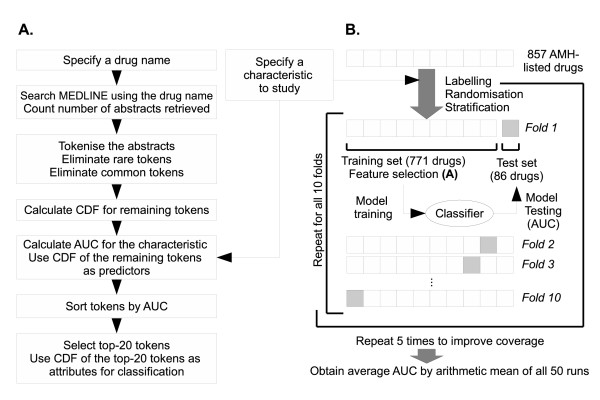
The workflow of BICEPP and the evaluation procedure. A. The procedures of feature derivation and feature selection. The features for the inputs of machine learning classifiers are the CDF of 20-most predictive tokens. The CDF of a token, given a drug, is defined as the proportion of abstracts containing the token within the list of abstracts retrieved by using the drug name as query to search MEDLINE. B. Cross-validation was performed to estimate the generalisation performance of BICEPP. The feature selection described in (A) was performed on the training set (which contains k-1 folds of data) and machine learning models were built to predict test set data. This figure illustrates the 5 × stratified up-to-10-fold cross-validation procedure used throughout the evaluation experiments in this paper. Abbreviations: AMH: Australian Medicines Handbook; AWT: abstract with title; AUC: area under ROC curve; CDF: conditional document frequency using the drug name as query to search MEDLINE; ROC: receiver operating characteristics;